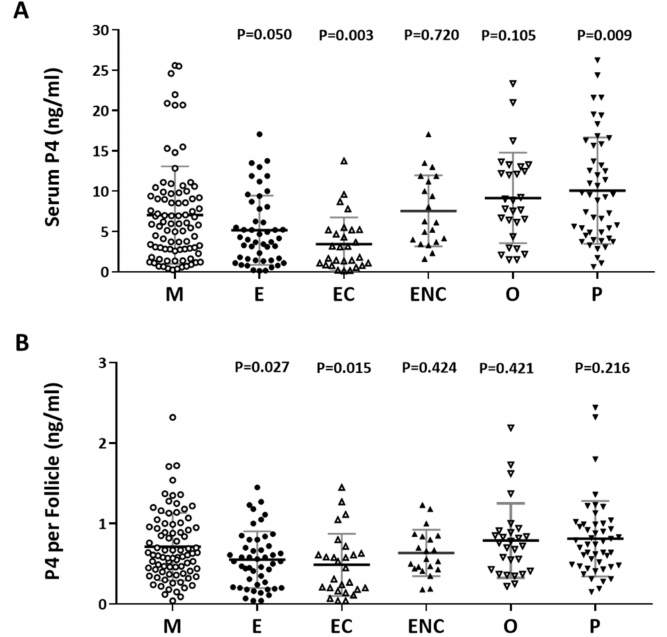
Figure 4. The relationship between serum P4 and cycle follicle outcomes in the various infertile groups. ( A ) Serum from each infertile group was collected, and serum P4 was analyzed by radioimmunoassay (RIA). ( B ) The serum P4 per follicle was compared in the various infertile groups of each patient group. The p -value for each group versus the male factor group was determined by an unpaired t